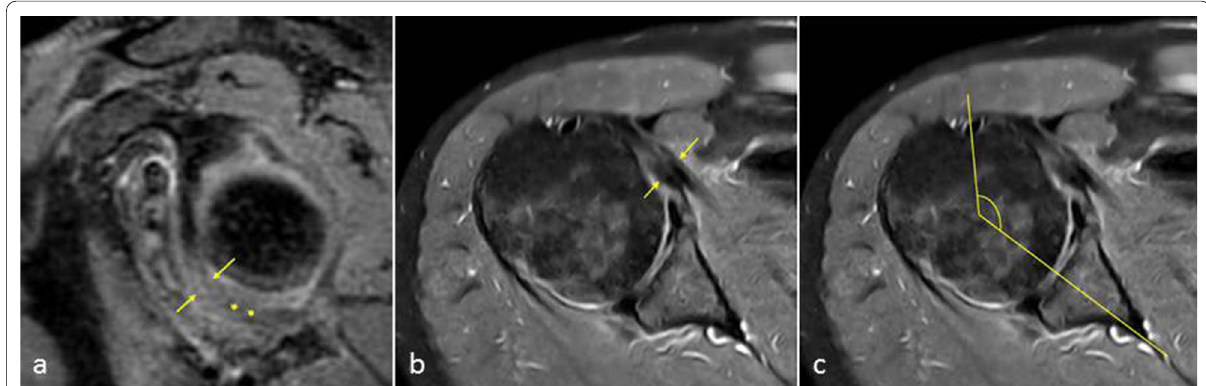
Fig. 6 A 47-year-old man with a clinical diagnosis of adhesive capsulitis (shoulder pain and limitation of movement). a Oblique sagittal PD VISTA SPAIR image illustrating a thickened (4.2 mm) anterior shoulder joint capsule (thin yellow arrows). A thickened and an increased signal intensity of the axillary shoulder joint capsule are also demonstrated (asterisks). b Axial fat-sat PD illustration of marked thickening and increased signal intensity of the anterior shoulder joint capsule is also noted (thin yellow arrows). c Same axial PD fat suppressed images showing angle of external rotation